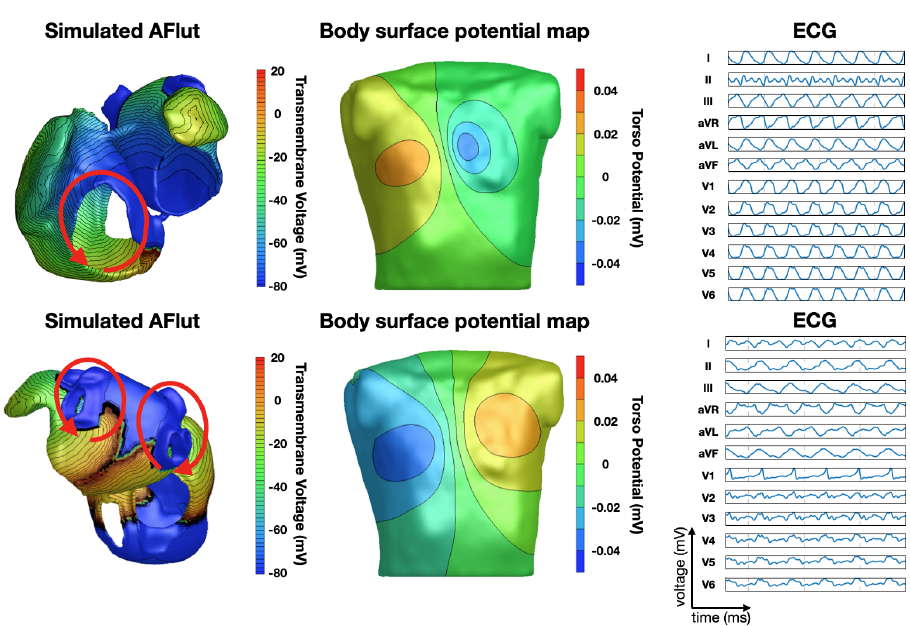
Figure 4. Examples of simulated AFlut transmembrane voltage distributions and the corresponding BSPMs and 12-lead ECGs. Top row: AFlut around the tricuspid valve in the counter-clockwise direction. Bottom row: figure-8 macro-re-entry around the left and right pulmonary veins in the anterior direction of rotation